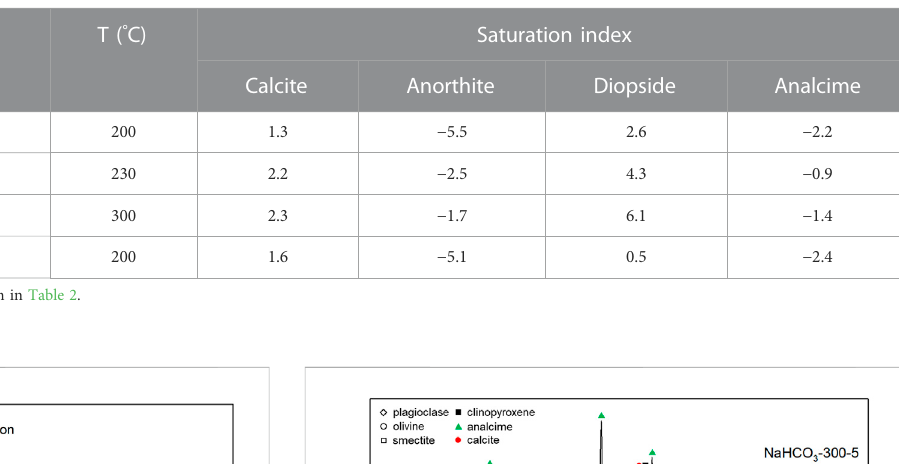
TABLE 3 Saturation indexes (SI) of minerals in the NaHCO 3 experiments.